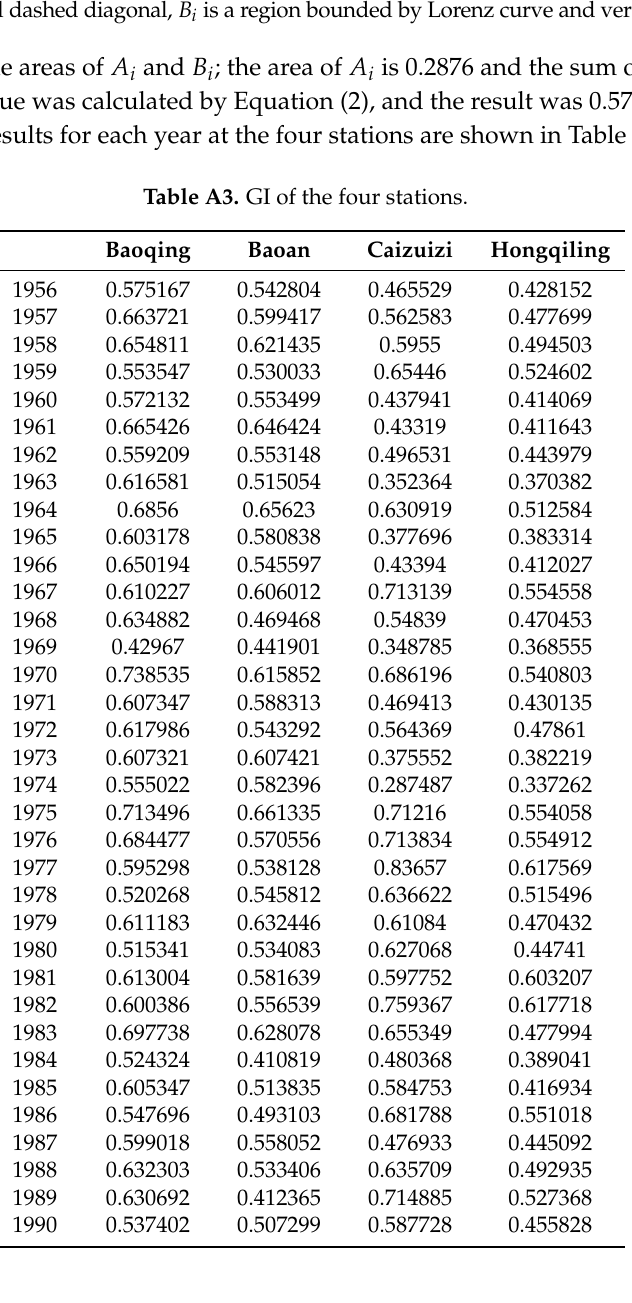
A is a region i